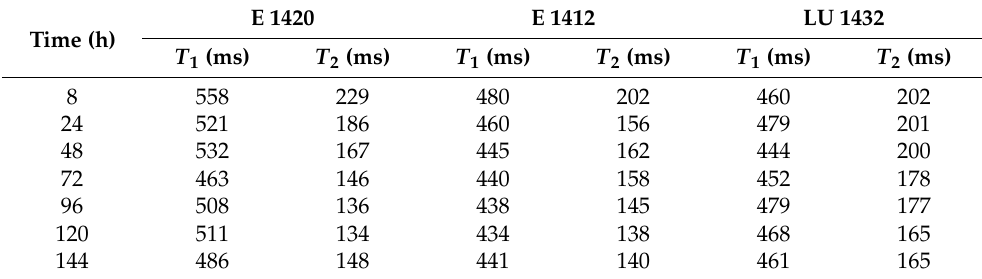
The values of relaxation times presented in the table indicate differences in T 1 values. The gels of unmodified potato starch (see [38]) and E 1421 starch show longer spin–lattice relaxation times than the E 1412 and LU 1432 starch gels, which suggests that E 1412 and LU 1432 bind water better. Such properties of starch gels may positively affect the long- term stability of food products in which these starches are used, suggesting their beneficial